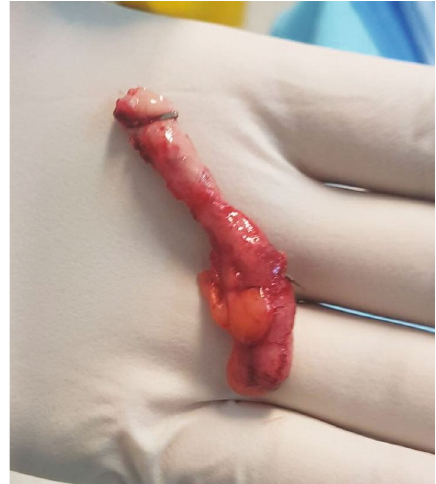
Figure 2: The in fl amed appendix and the metal object penetrating from it.